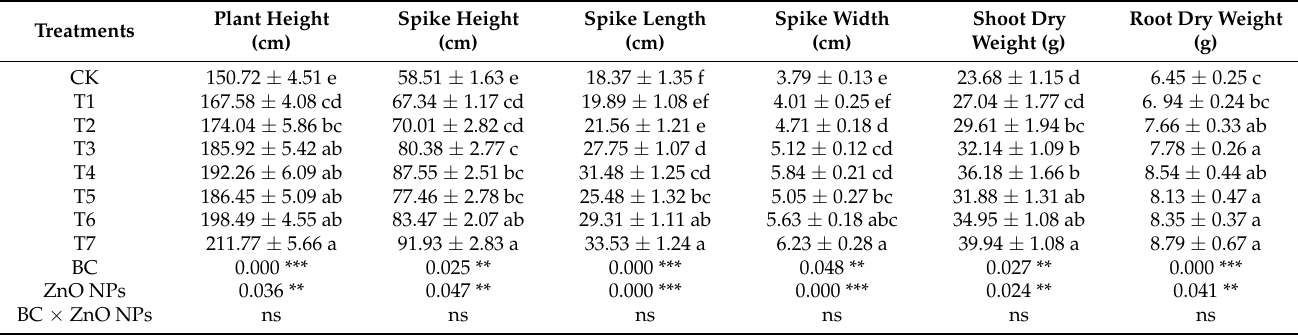
Table 1. Growth responses of corn by using bamboo biochar and foliar application of ZnO NPs. Treatments